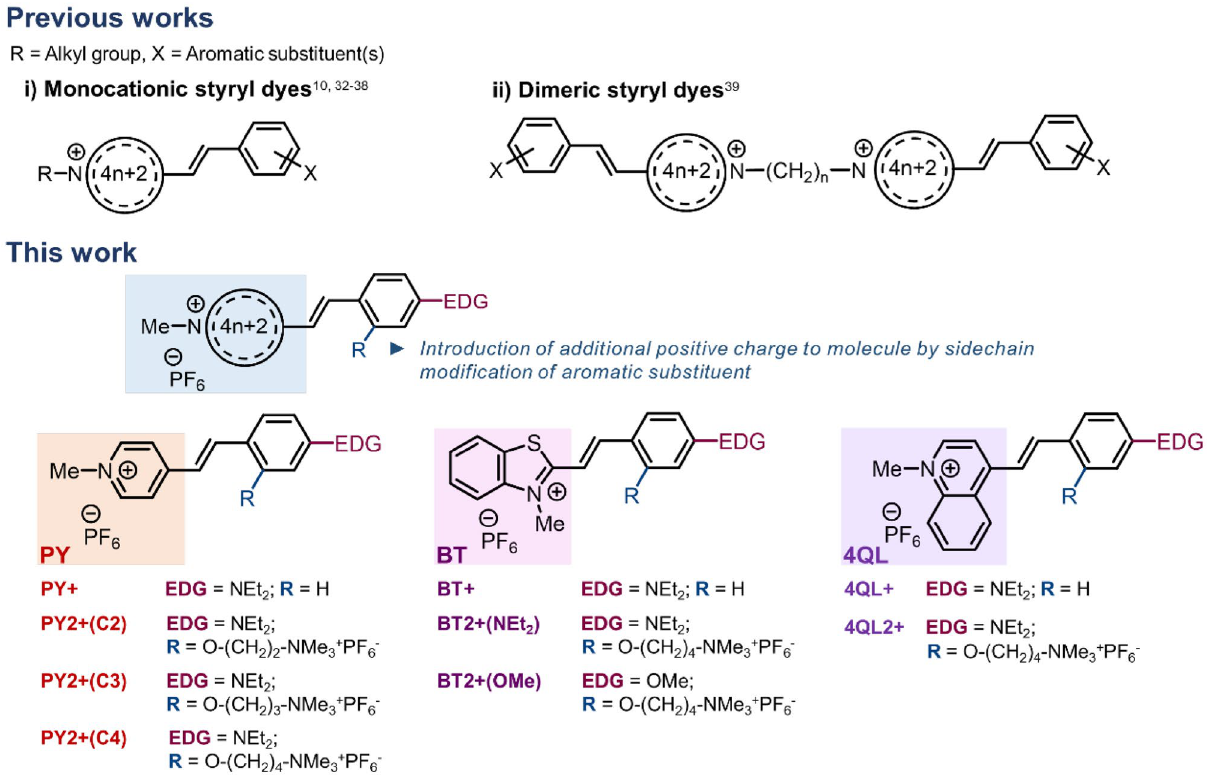
Figure 1. The designs of cationic styryl dyes previously reported and in the present